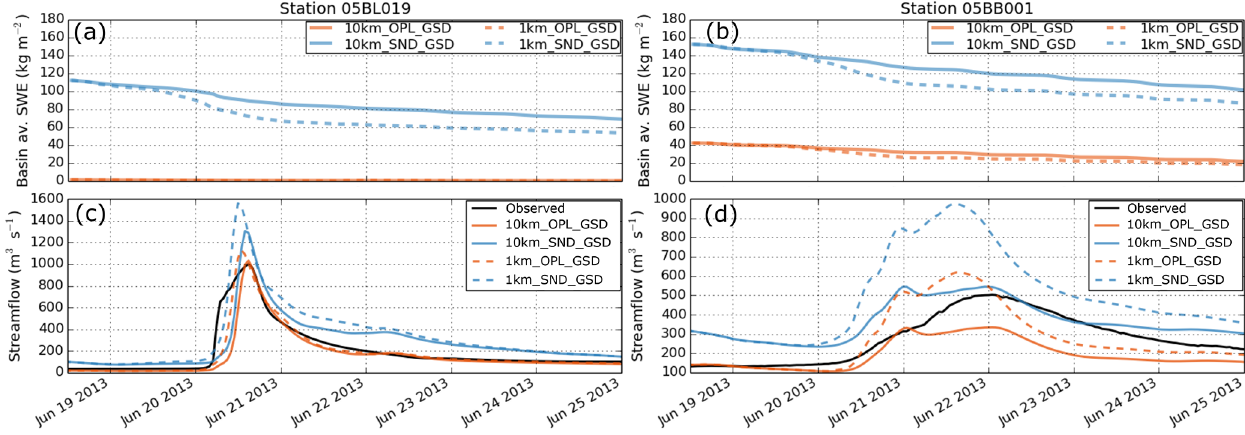
Figure 12. Snow and streamflow simulations at two hydrological stations: station 05BL019 (a, c) and station 05BB001 (b, d) . (a, b) Basin- averaged SWE for four GEM-Hydro simulations; (c, d) observed and simulated streamflow. Note the different y axis on each graph.